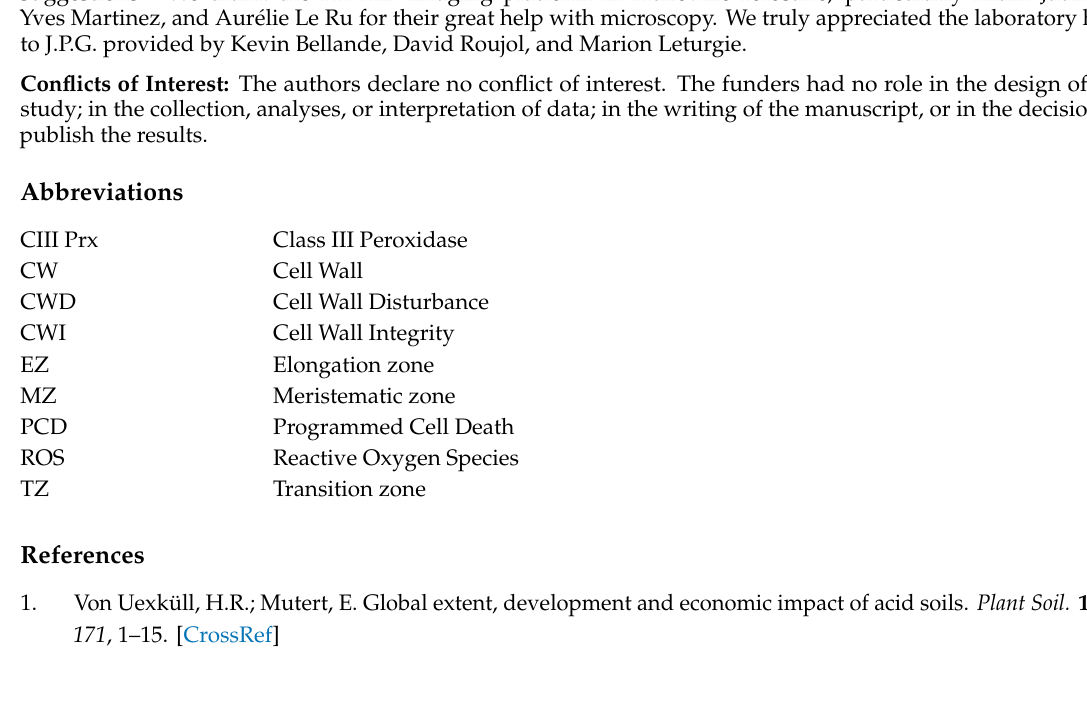
s1. Supplementary Table S1: Transcriptomics data mining for CIII Prx multigenic family expression following low pH treatment of A. thaliana roots reveals AtPrx62 as the most promising candidate gene for involvement in low pH-induced cell death in roots. Supplementary Figure S1: Identification of root zones in 5 day old seedlings of A. thaliana (Col-0) based on activity of CIII Prx and O2 •− distribution. Supplementary Figure S2. Measurement of H2O2 in root tips of A. thaliana (Col-0) after treatment at pH 5.8 or 4.6. Supplementary Figure S3. CIII Prx activity in A. thaliana Col-0 and atprx62-1 (KO mutant) treated at pH 5.8 or 4.6 for 2 h. Supplementary Figure S4. NBT reaction showing O2 •− distribution in roots of A. thaliana Col-0 and atprx62-1 (KO mutant) treated at pH 5.8 or pH 4.6 for 2 h. Supplementary Figure S5. Biological replicates for whole-mount in situ